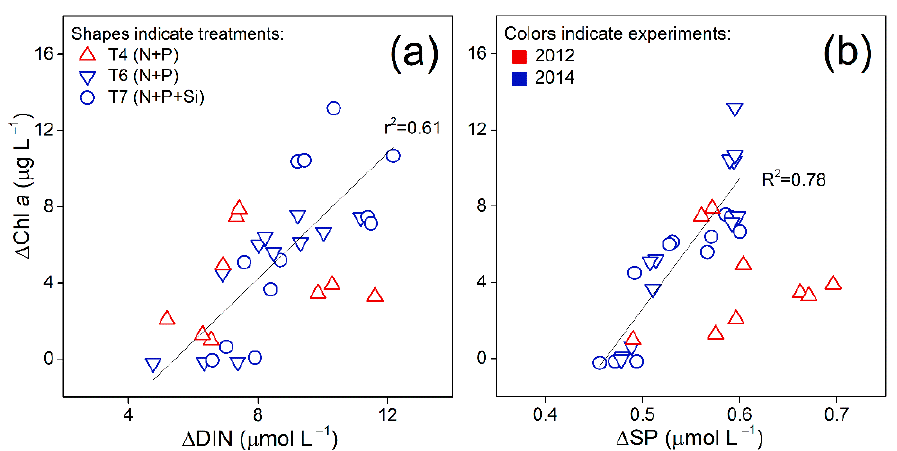
Figure 4. Change of Chlorophyll a ( ∆ Chl a ) concentrations versus ( a ) DIN consumption ( ∆ DIN) and ( b ) phosphate consumption ( ∆ SP), calculated using the initial DIN or SP concentrations (including additions and seawater background) minus their concentrations at the sampling